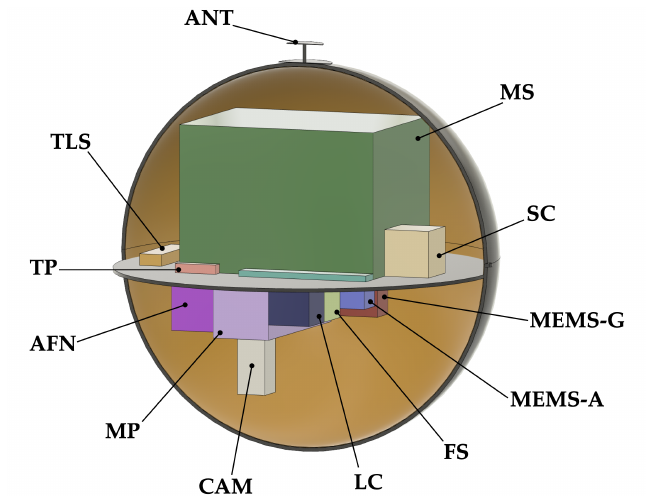
Figure 7. A schematic of a gondola for the VAIHL Mission. Non-science subsystems, except for the antenna, are not